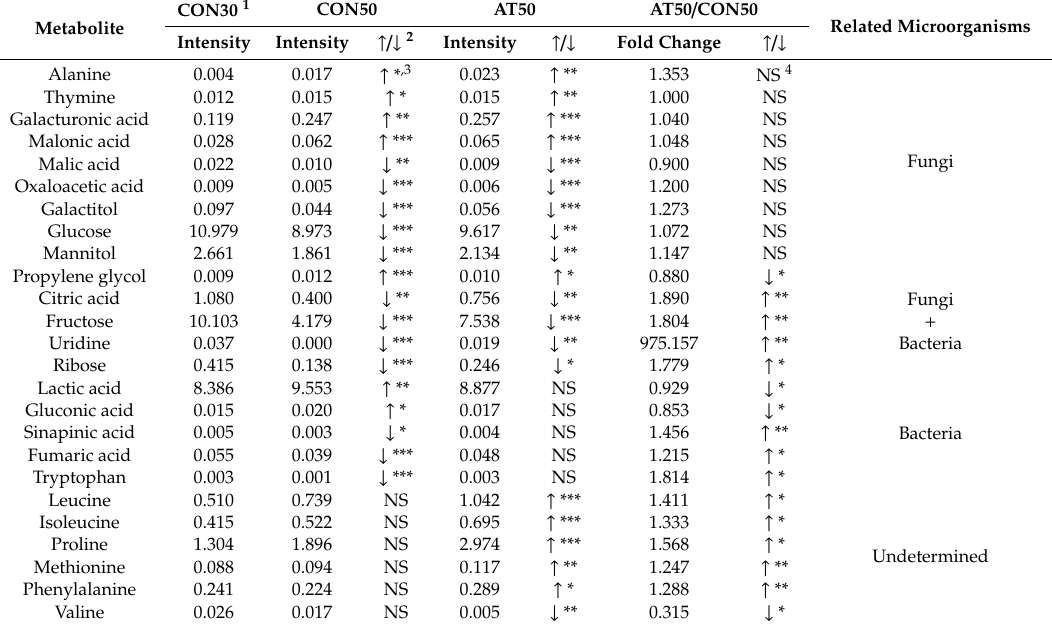
Table 1. Significantly di ff erent metabolites between the control and ampicillin-treated group after 50 days of kimchi